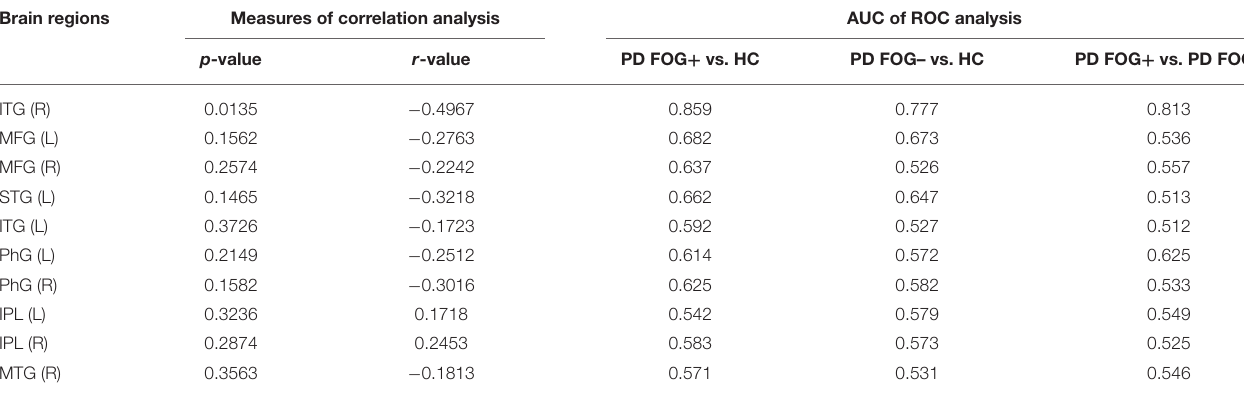
TABLE 2 | Correlation and ROC analysis results of 10 brain regions with significantly different DC in PD FOG + vs. HC. Brain regions Measures of correlation analysis AUC of ROC